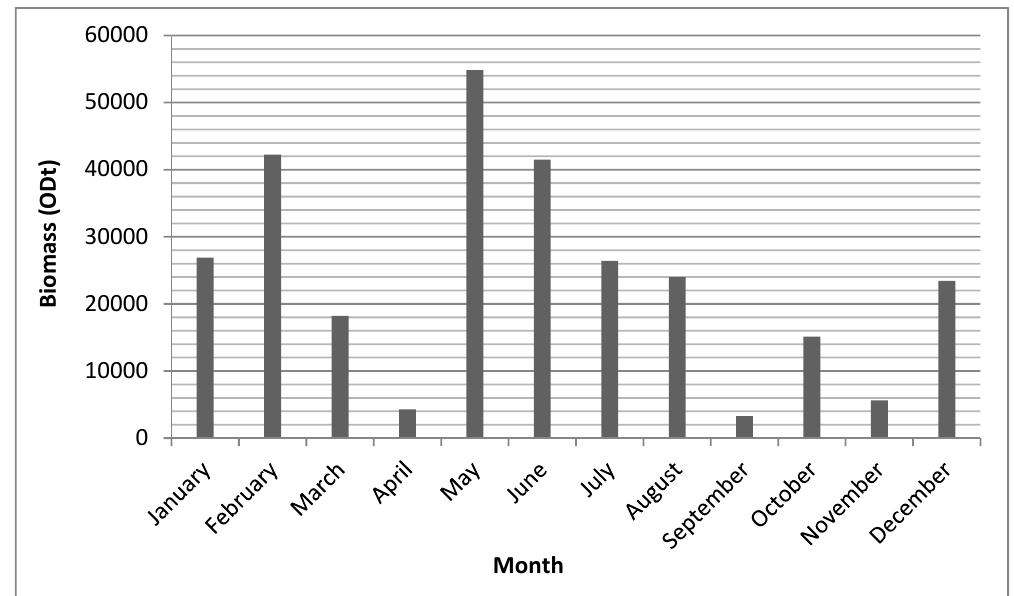
Figure 5. Monthly amount of woody biomass consumption at the AGS to meet electricity power production requirements (BASE